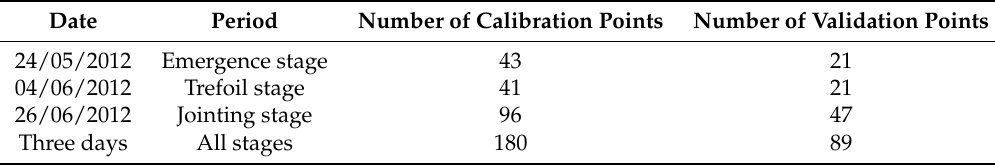
Table 4. The number of calibration and verification sampling points.